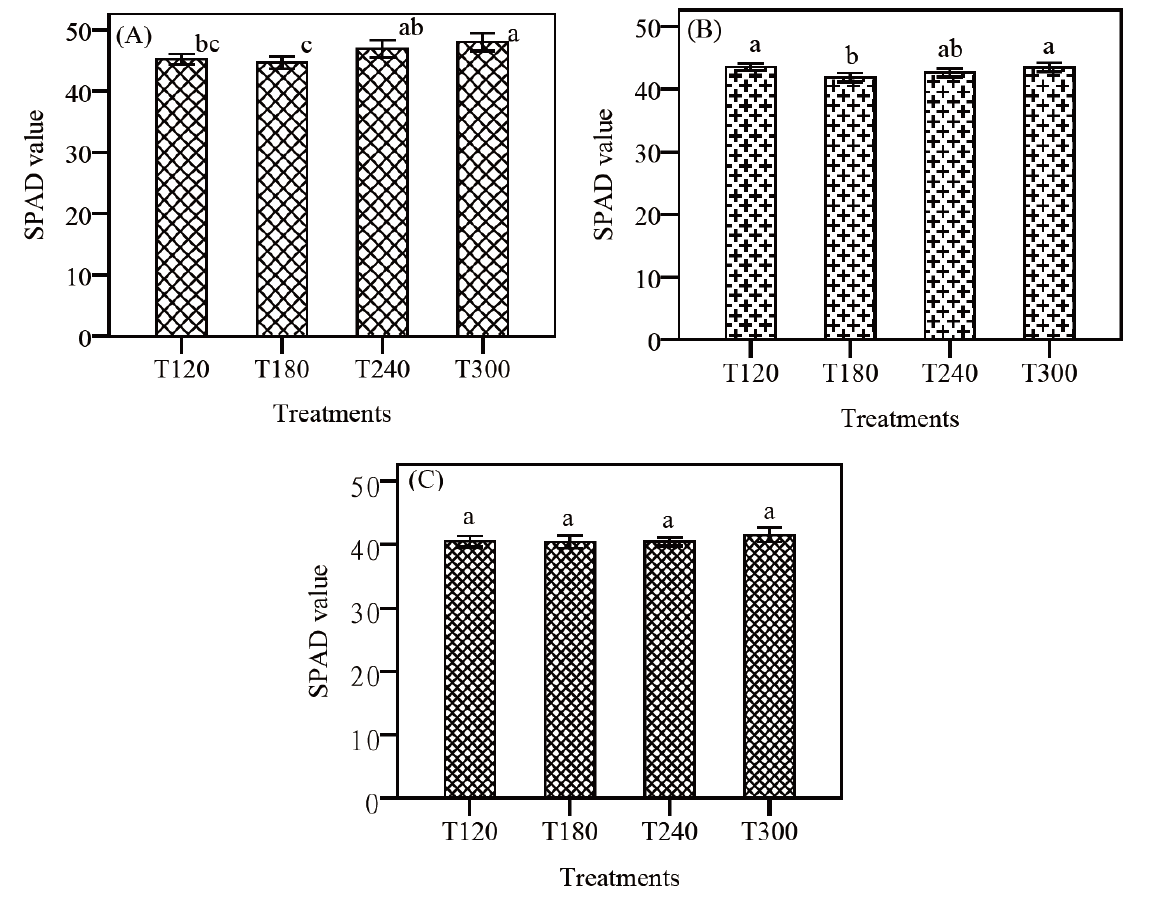
Figure 4. Effects water treatments on chlorophyll content: ( A ) at active tillering, ( B ) at panicle initiation and ( C ) at heading.